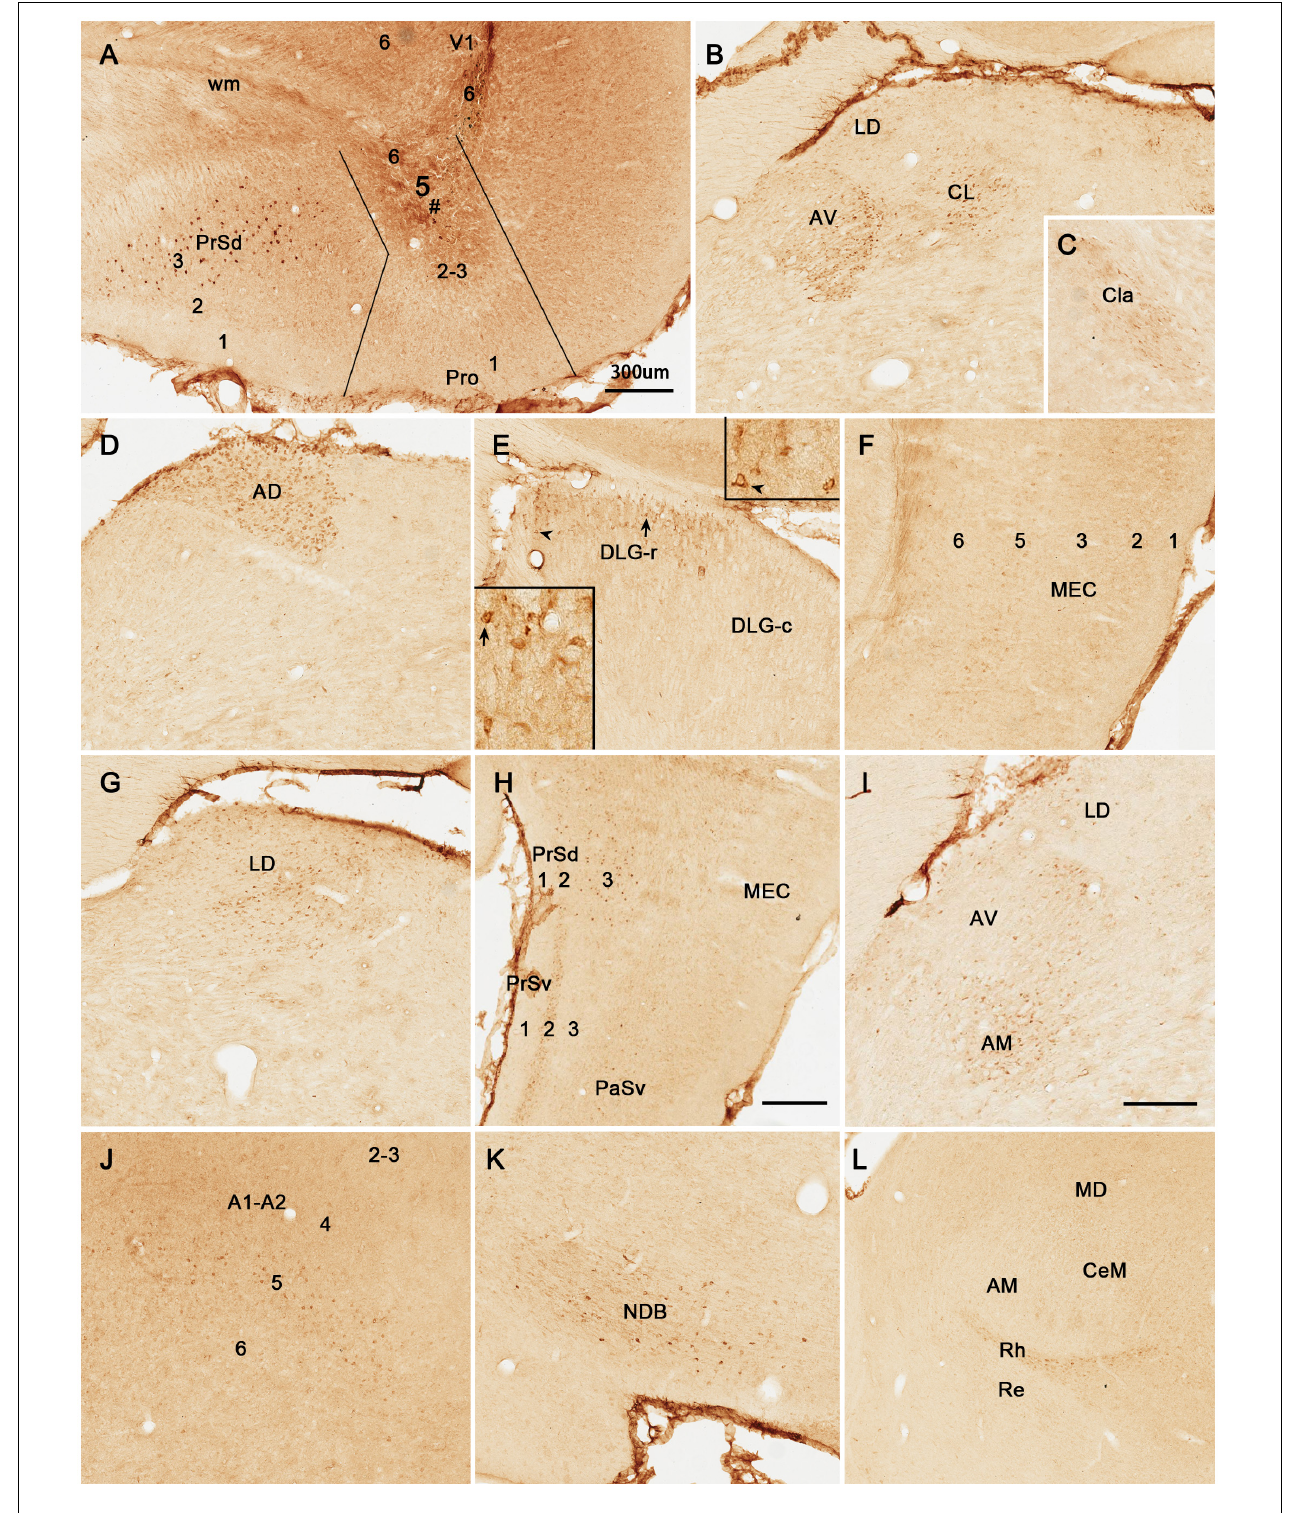
FIGURE 3 | Examples of retrogradely labeled neurons resulted from another Fluoro-Gold (FG) injection in rat prostriata. All panels are from sagittal sections. In this case, FG was turned into non-fluorescent products via immunohistochemistry with anti-FG antibody. The injection (#) is mainly located in the prostriata (Pro) with involvement in layer 6 of overlying V1 (A) . Retrogradely labeled neurons are shown in layers 2–3 of PrSd (A,H) , anteroventral thalamic nucleus (AV) and CL (B) , claustrum (Cla in C ), AD (D) , DLG-r (E) , layers 2 and 5 of medial entorhinal cortex (MEC) (F) , LD (G) , AM (I) , layer 5 of A1–A2 (J) , nucleus of diagonal band (NDB in K ), and rhomboid nucleus (Rh in L ). Note the two insets in (E) showing high power views of the labeled neurons indicated by arrow and arrowhead, respectively. Bars: 300 µ m (A) for (A–G,J–L) ; 350 µ m (H) ; 250 µ m (I) . Frontiers in Neuroscience |